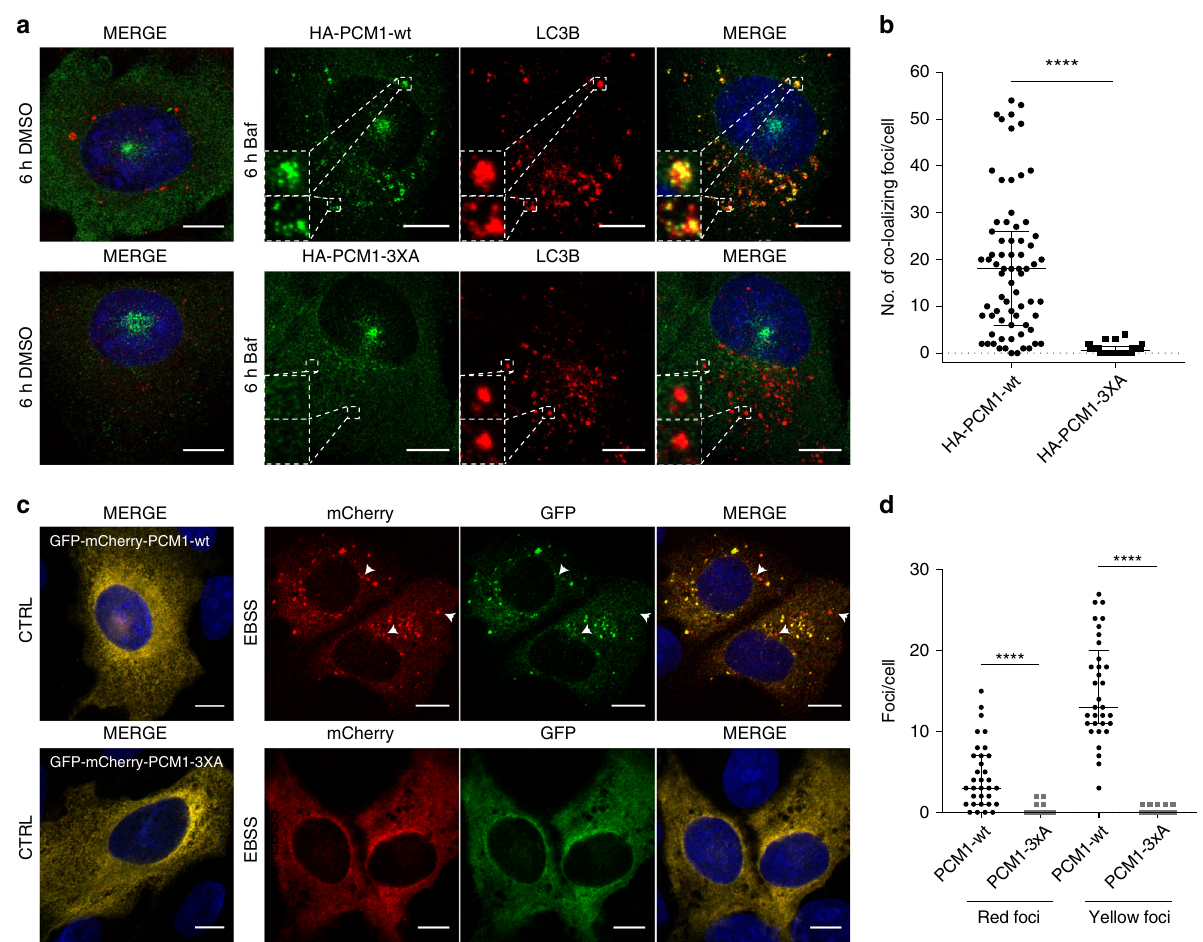
Fig. 7 The PCM1 LIR domain is required for its autophagosomal engulfment. a Colocalization of LC3B with HA-PCM1-wt or HA-PCM1-3XA constructs in U2OS cells treated for 6 h with 200 nM Baf and stained for HA, LC3B and Hoechst33342. b Quanti fi cation of ( a ). The number of co-localizing foci per cell were quanti fi ed, n = 3 of each >20 cells. Bars represent medians and interquartile range. **** P ≤ 0.0001. Two-tailed Mann – Whitney test. c Traf fi c-light- assay of GFP-mCherry-PCM1 or GFP-mCherry-PCM1-3XA in U2OS cells following 2 h of EBSS treatment showing formation of yellow and red foci for PCM1, the latter indicating lysosomal localization. Arrows indicate examples of red foci. d Quanti fi cation of ( c ). The number of yellow and red foci per cell were quanti fi ed, n = 3 of each ≥ 10 cells. Bars represent medians and interquartile range. **** P ≤ 0.0001. Two-tailed Mann – Whitney test. Scale bars, 10 µ m. Source data are provided as a Source Data fi